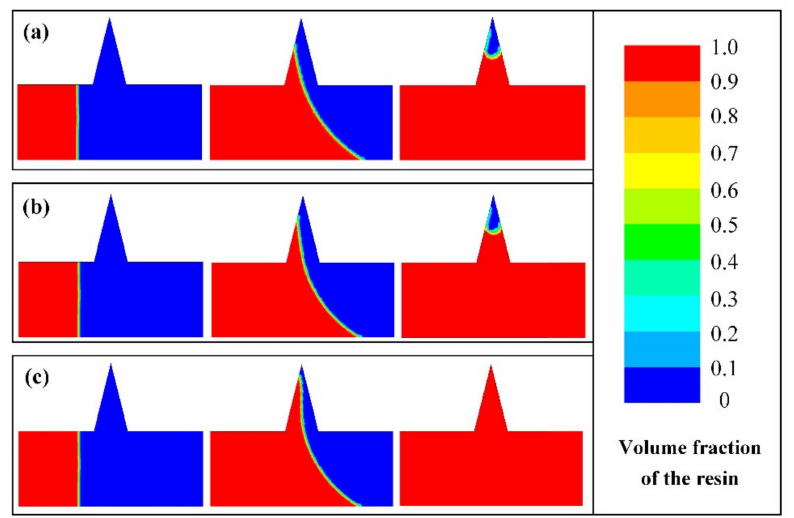
Figure 14. The resin filling evolution process with different slip velocity ( a ) 0 m/s ( b ) 1.0 × 10 − 5 m/s ( c ) 2.0 × 10 − 5